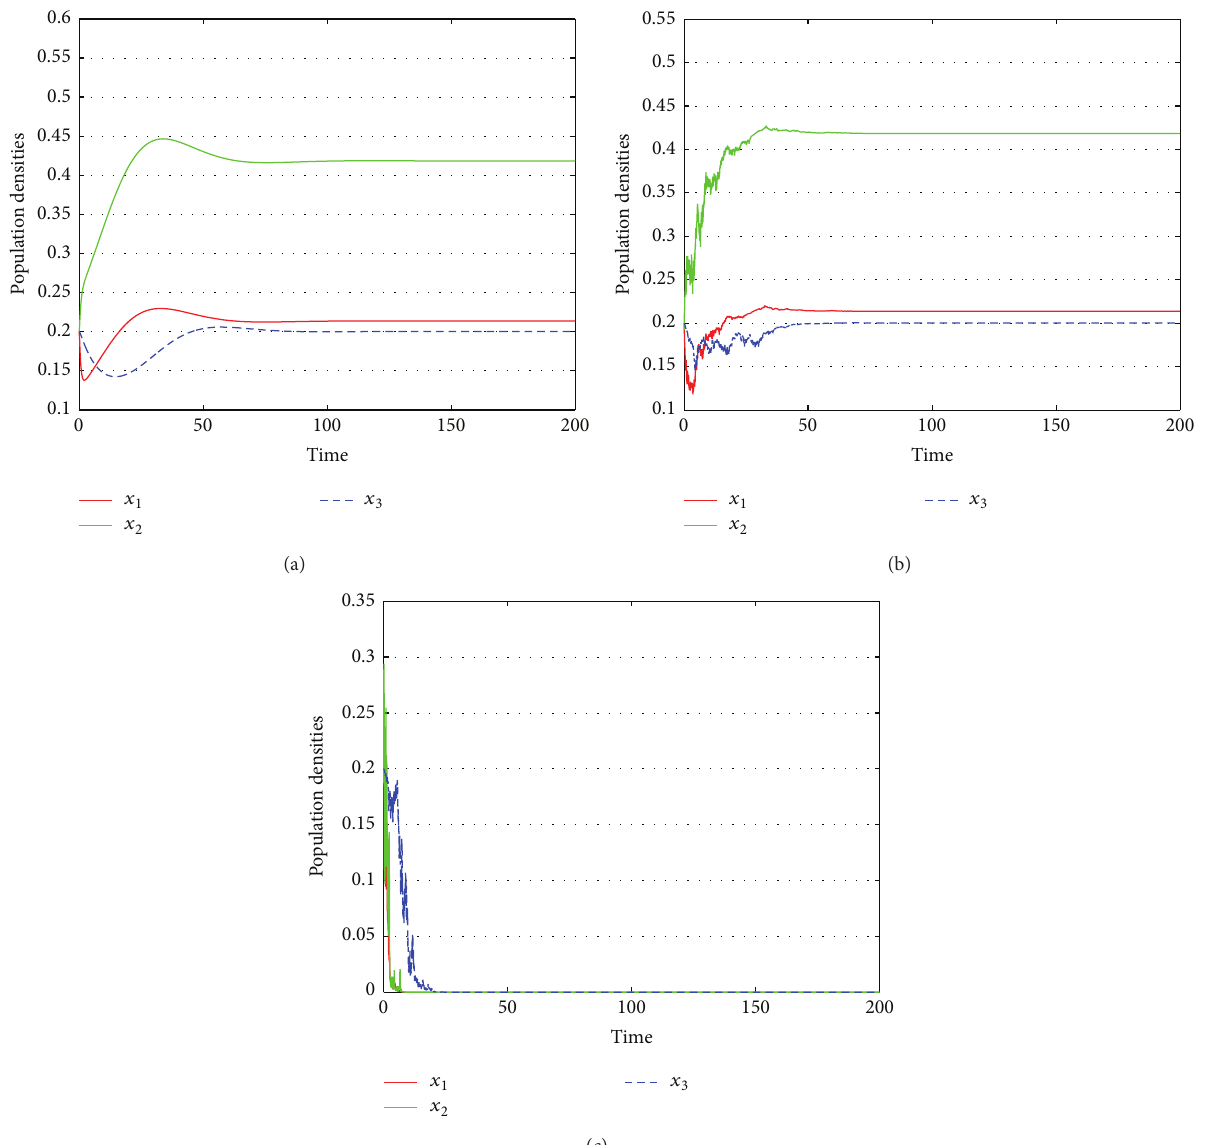
Figure 1: Solution of system (3) with initial conditions 𝑥 1 (0) = 𝑥 2 (0) = 𝑥 3 (0) = 0.2 and 𝑟 = 0.6 , 𝑑 1 = 0.2 , 𝑎 11 = 0.3 , 𝑏 = 0.8 , 𝑎 13 = 0.6 , = 0.3 , 𝑎 = 0.2 , 𝑎 = 0.3 , 𝑑 = 0.1 , 𝑘 = 5/6 , 𝑘 = 0.8 , 𝑎 = 0.2 , Δ𝑡 = 0.01 , 𝑚 = 0.3 , 𝑛 = 0.1 , 𝛼 = 2 , and 𝛽 = 1 . (a) 𝜎 𝑑 2 22 23 3 1 2 33 = 1.9 , 𝜎 2 = 0.6 , and 𝜎 2 = 1.9 . (c) 𝜎 2 = 20 , 𝜎 2 = 20 , and 𝜎 2 = 20 𝜎 2 1 2 3 1 2 3